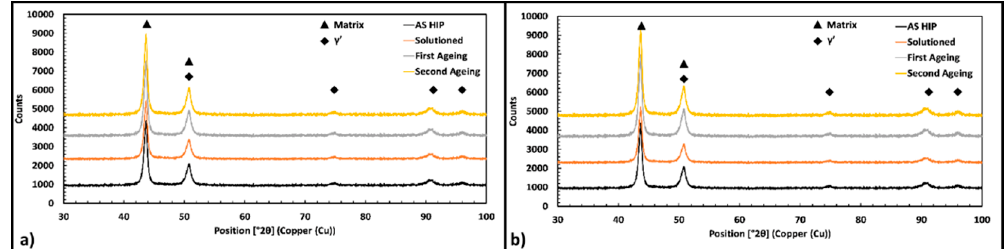
Figure 14. X-ray diffraction (XRD) patterns obtained from Astroloy samples in LT Figure 14. X-ray di ff raction (XRD) patterns obtained from Astroloy samples in LT metallurgical metallurgical condition a ) and in HT b ) respectively. condition ( a ) and in HT ( b )